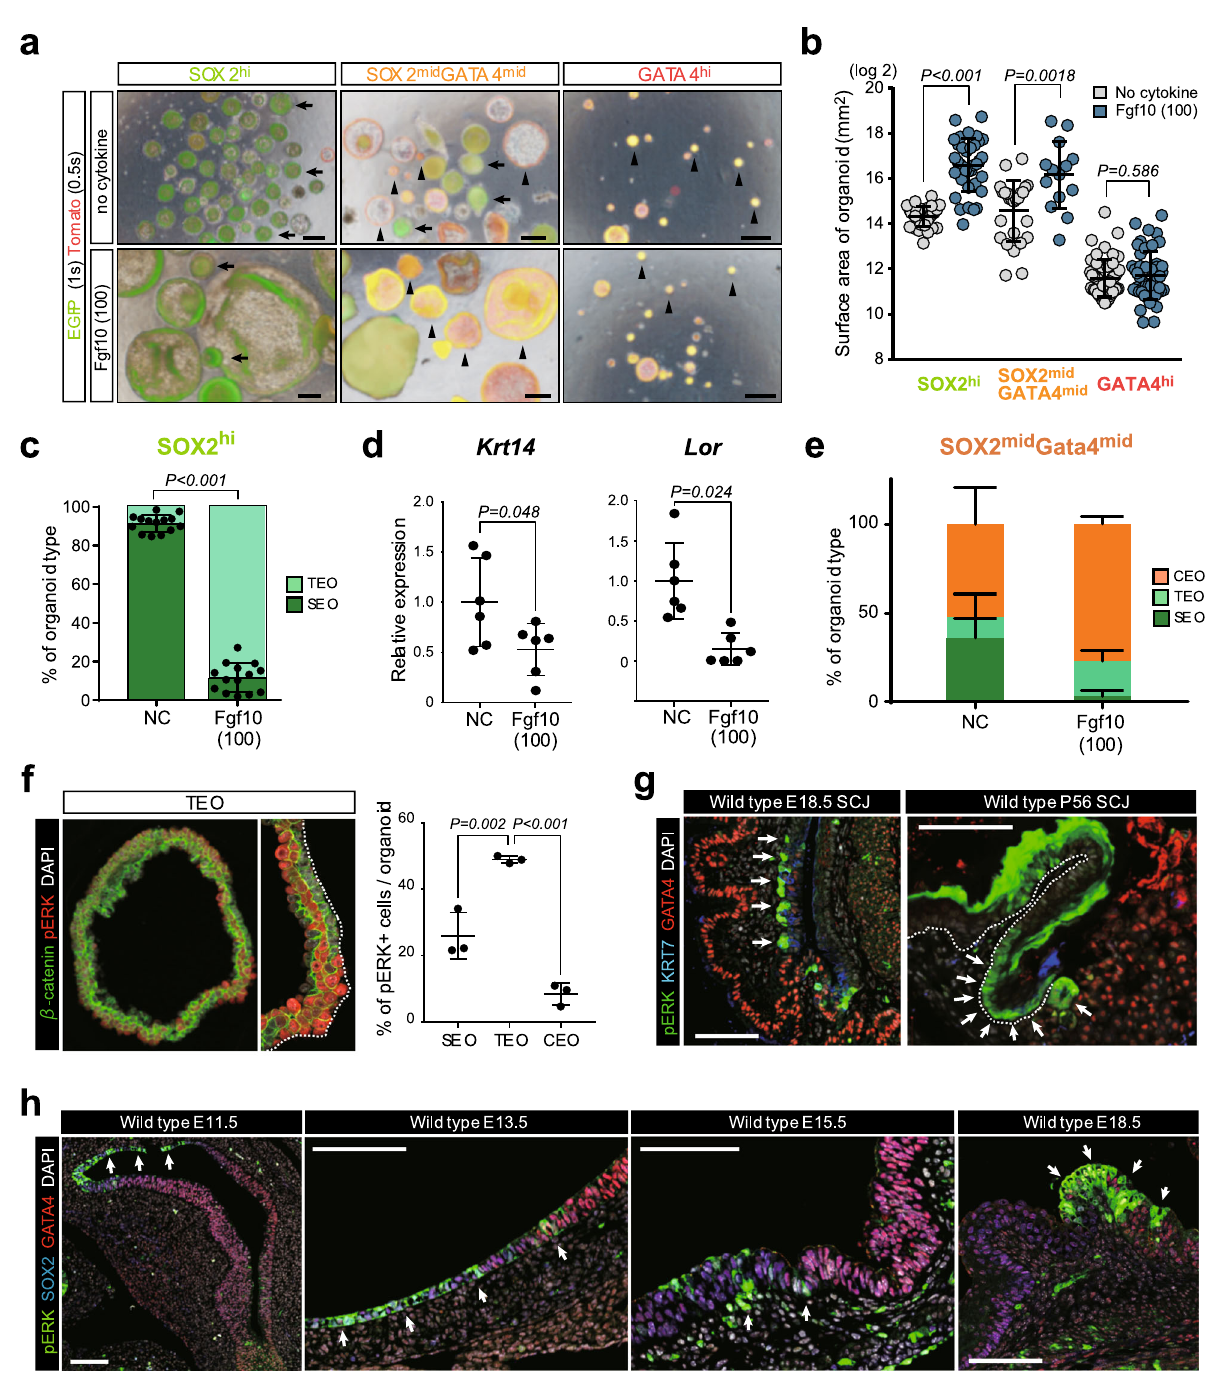
Fig. 5 Activation of MAPK/ERK prevents the differentiation of KRT7 + transitional epithelial cells. a Fluorescent images of organoids generated from Sox2 hi , Sox2 mid Gata4 mid , and Gata4 hi cells in the culture condition with no cytokine (NC) or FGF10 (100 ng/mL). Arrows indicate the SEOs and arrowheads indicate CEOs. n = 5. Scale bar, 100 µ m. b Surface areas of organoids generated from Sox2 hi , Sox2 mid Gata4 mid , and Gata4 hi in the culture condition with NC or FGF10 (100 ng/mL). n > 13 organoids of three independent experiments, two-sided t -test. c Quanti fi cation of organoid types generated from Sox2 hi cells in the culture condition with NC or FGF10 (100 ng/mL). n = 14 independent experiments, two-sided t -test. d Quantitative (Q)-PCR analyses of Krt14 and Lor for organoids generated from Sox2 hi cells in the culture condition with NC or FGF10 (100 ng/mL). The CT value of each gene is normalized by B2M . The average Δ CT value of the NC condition is set to 1. n = 6 independent experiments. Data are presented as mean values ± SD, two-sided t -test. e Quanti fi cation of organoid types generated from Sox2 mid Gata4 mid cells in the culture condition with no cytokine (NC) or FGF10 (100 ng/mL). n = 4 independent experiments. Data are presented as mean values± SD. f Left: IF analysis of phospho-ERK (pERK) and β -catenin for TEOs. Presented data are a representative image of n > 10 organoids out of three independent experiments. Scale bar, 100 µ m. Right: quanti fi cation of pERK + cells in SEOs, TEOs, and CEOs. n = 3 independent experiments, one-way ANOVA. g IF analyses of pERK, KRT7, and GATA4 for the wild-type stomachs at E18.5 and postnatal day 56. Arrows indicate the pERK + KRT7 + transitional epithelial cells in the SCJ. Presented data are a representative image of n = 5. Scale bar, 100 µ m. h IF analyses of pERK, SOX2 and GATA4 for wild-type stomachs at E11.5, E13.5, E15.5, and E18.5. Arrows indicate the pERK + epithelial cells in the boundary between proximal and distal stomachs. Presented data are a representative image of n = 5. Scale bar, 100 µ m. NATURE COMMUNICATIONS| (2021) 12:560